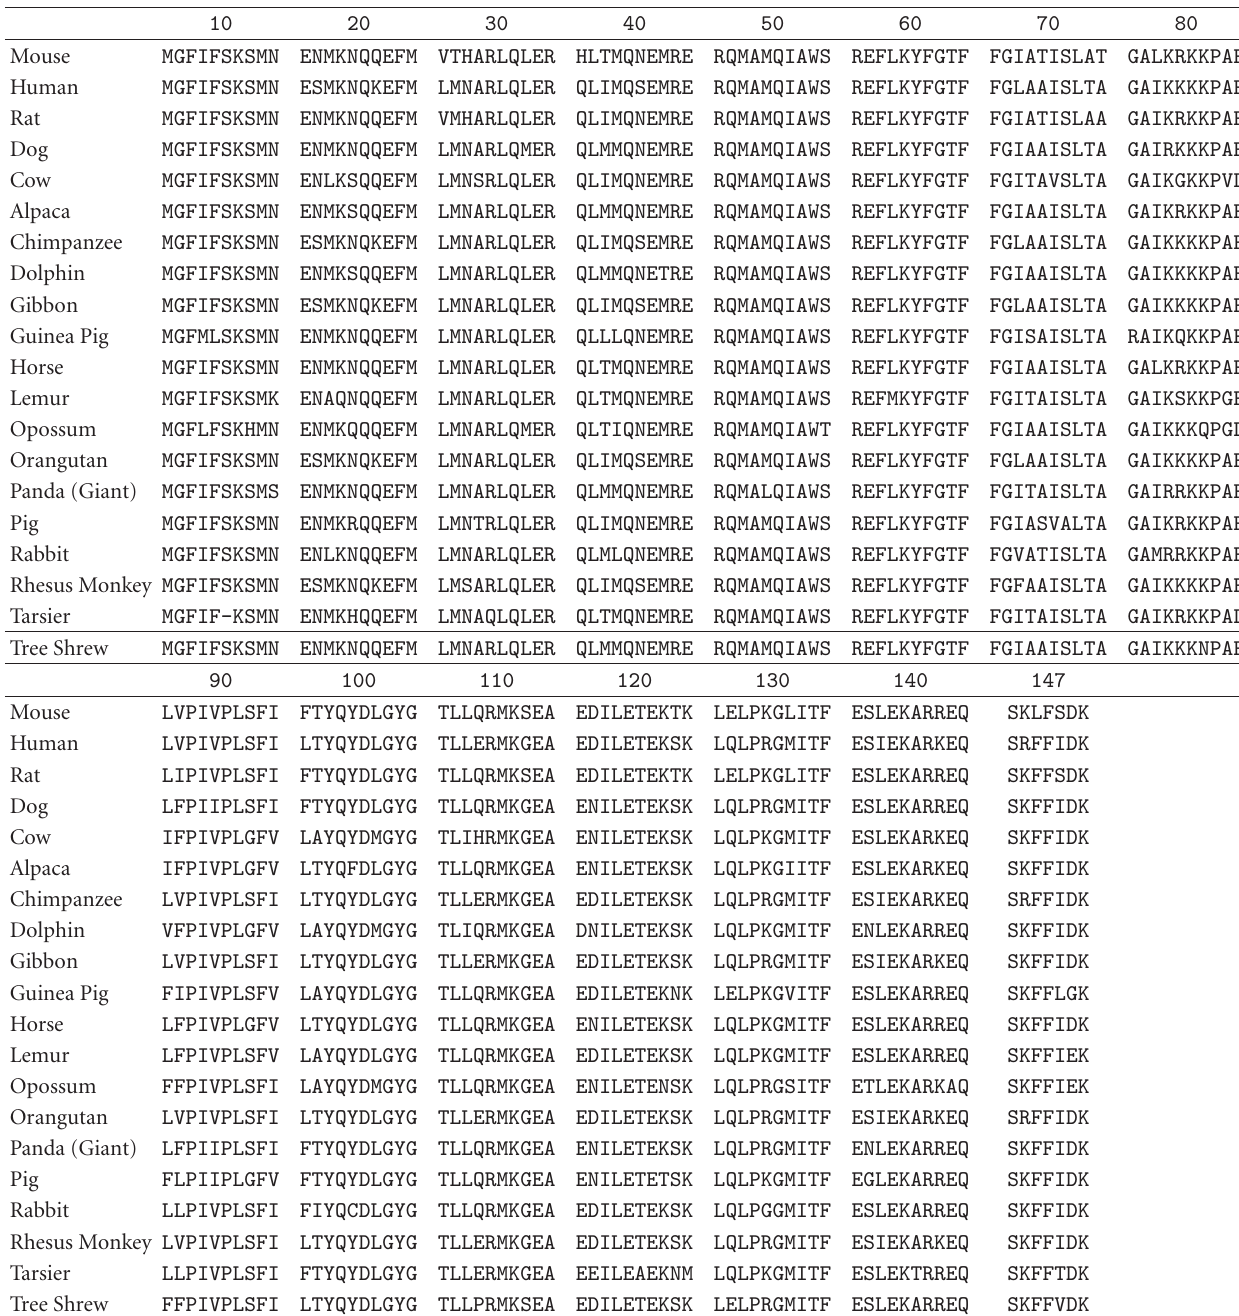
Table 1: Alignment of Mammalian Orthologs of Plg-R KT